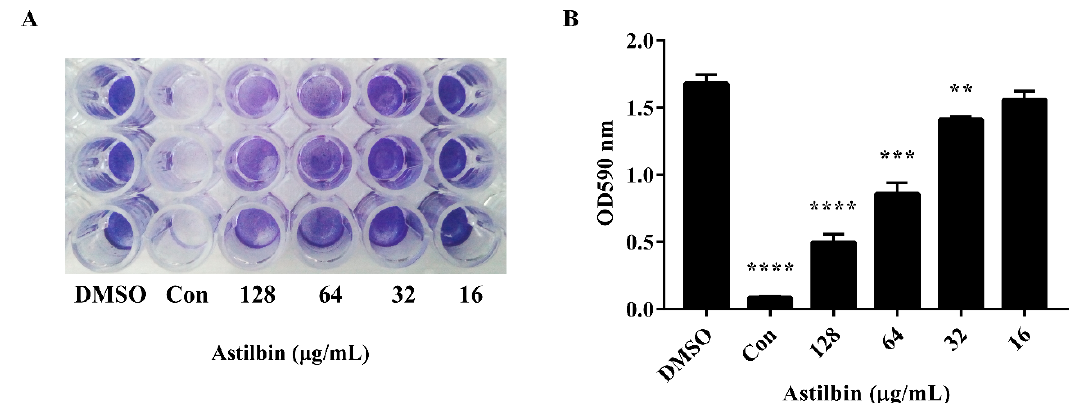
Figure 3. Inhibition of S. mutans biofilm formation by astilbin. ( A ) Photograph of S. mutans biofilms grown in the wells of a 96-well plate. Cells were cultured in BHI media containing different concentrations of astilbin for 16 h and stained with 0.1% crystal violet. The group treated with 128 µ g/mL of morin served as a positive control (Con). The DMSO treatment group served as a negative control. ( B ) Quantification of the biomass of S. mutans treated with astilbin. The data were obtained from three independent experiments. Significant differences between groups were accepted at ** p < 0.01, *** p < 0.001, and **** p < 0.0001.